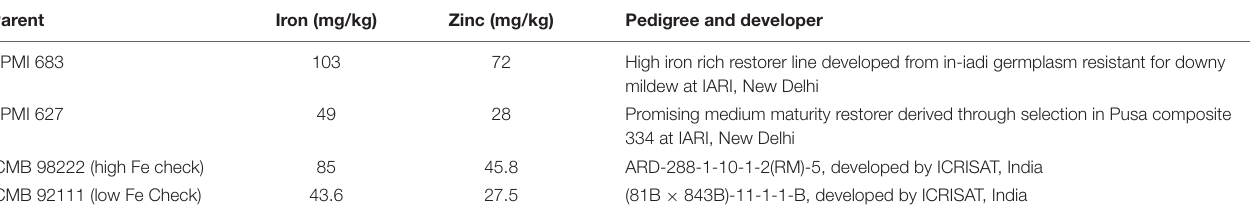
TABLE 1 | Pedigree of the parental lines used to develop F 6 : 7 mapping populations along with the high and low iron checks. Parent